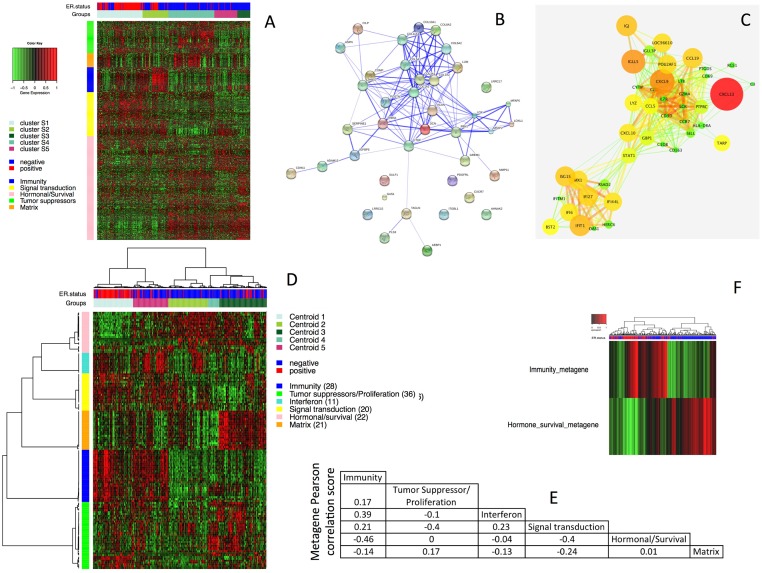
Gene selection process.A Heatmap showing the 616 most variable genes in the 448 HER2-positive samples (training set). B String database software confidence view of the Matrix genes cluster. Stronger associations between genes are represented by thicker lines. C Cytoscape View for the Immunity gene cluster. GE correlations between genes are indicated by edges (edge color varies from green to red and edge size increases with increasing correlation) and gene expression variance is represented by node color (node color varies from green to red and node size increases with increasing variance). D Heatmap showing the relative expression of 138 selected genes in 448 HER2-positive samples from the training set. E Table of Pearson’s correlation coefficient values for the correlations between the 6 metagenes. F Heatmap showing the anticorrelation between the Immunity and the Hormone/Survival metagene.